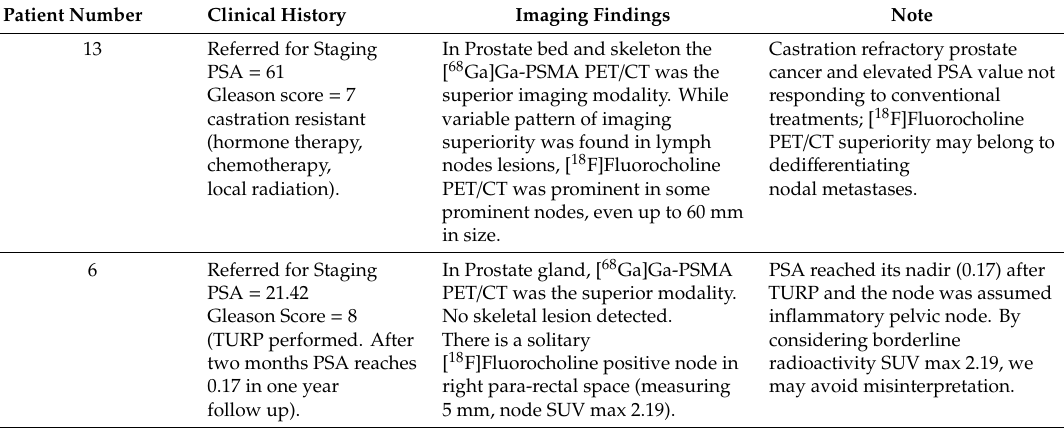
Table 4. Discrepant nodal metastases exclusively detected on [ 18 F]Fluorocholine PET / CT; 7.3% of all nodal